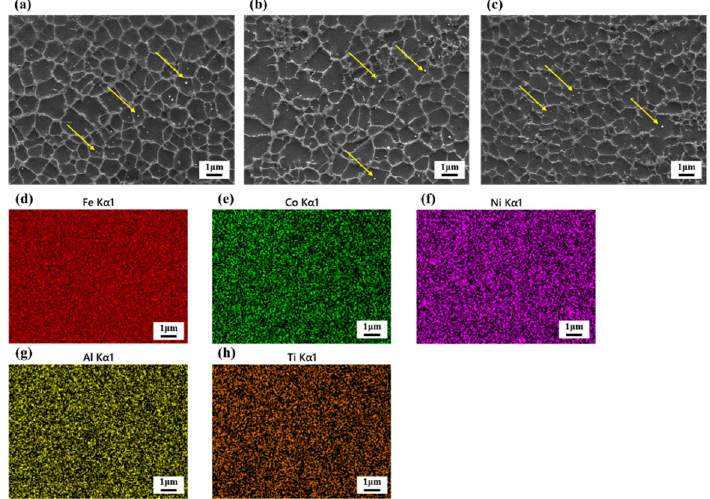
Figure 6. SEM images and the EDS of the SLM-fabricated composites with different scanning speeds: ( a ) 650 mm/s, ( b ) 800 mm/s and ( c ) 1000 mm/s. ( d – h ) The EDS distribution of the SLM-fabricated composites at 650 mm/s.